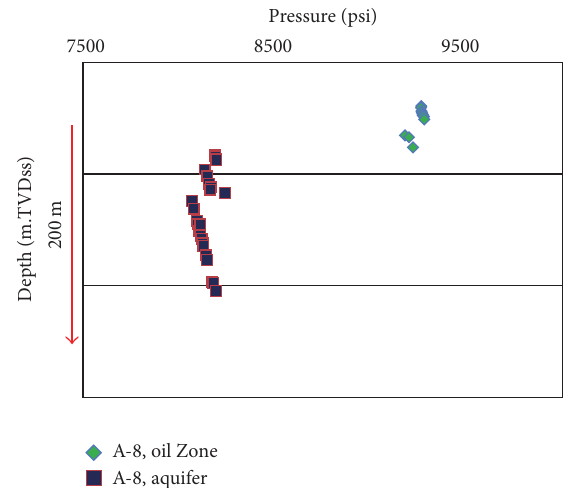
Figure 10: Reservoir pressure versus depth in well A-8. The green points are from oil zone and the blue points are from water zone (basedonthetestresults).Thestep-stairpressurepatterncanbeseen in both oil and water zones.